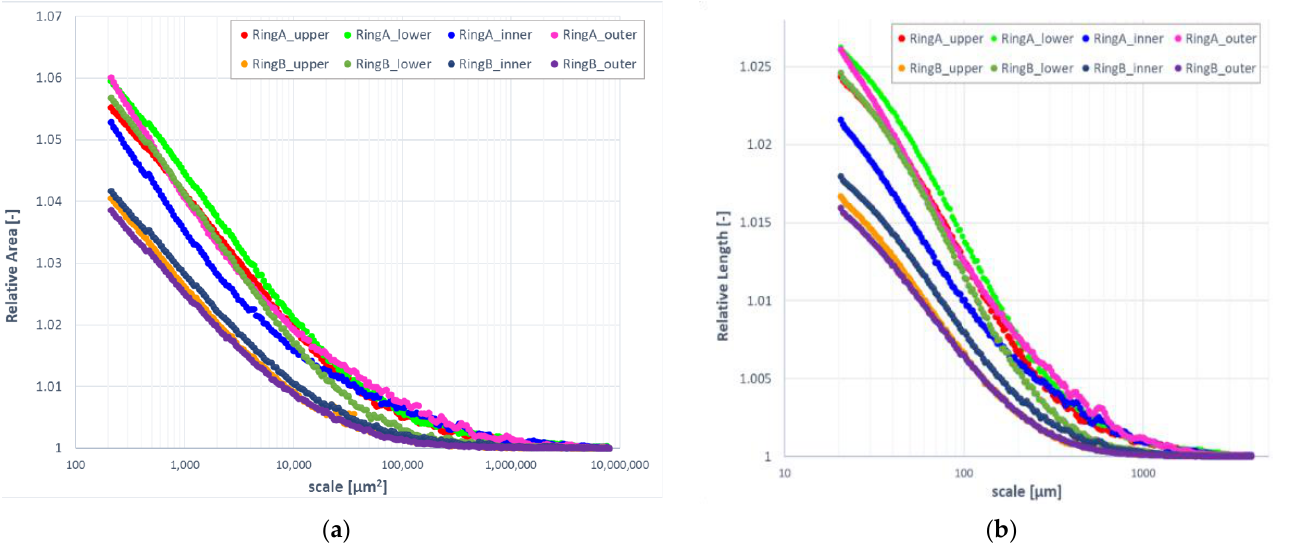
Figure 8. Evolution of relative area ( a ) and length ( b ) as a function of scale.